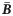
Box plots depicting the empirical distribution of the bar-chart parameters, Fleiss’ kappa and the mean ratio B¯.P0 –proportion of trees marked “0” by all raters, Pm−proportion of trees marked in the 20% highest classes of the marking bar chart, rv−coefficient of variation of the proportions of the rater bar chart, c¯–mean conformity number, κF –Fleiss’ kappa, B¯ - mean ratio of the proportion of number of trees marked with “1” and the proportion of basal area of these trees, see Section “Statistical measures of interrater agreement”.